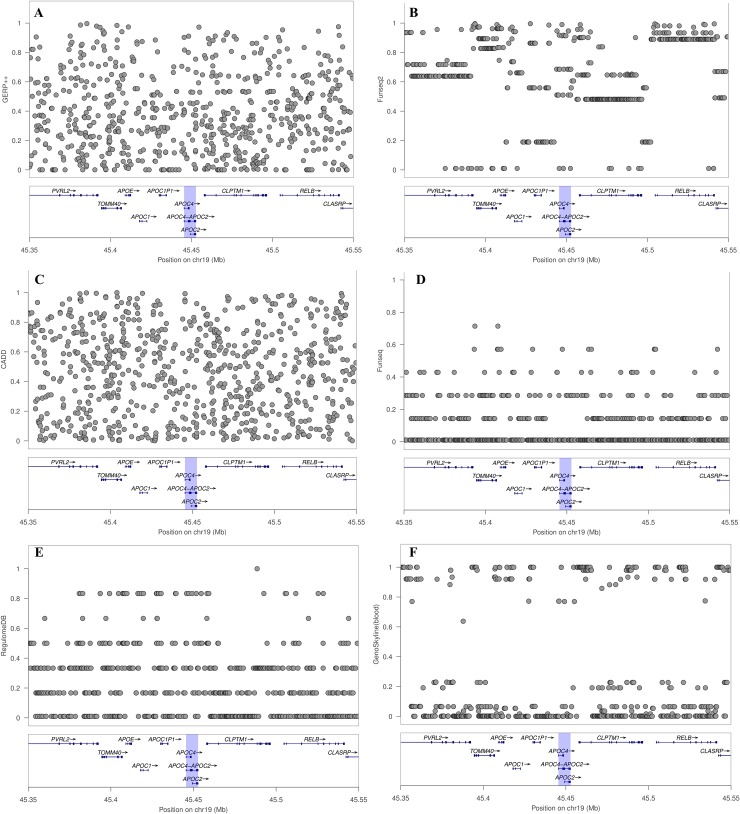
Rescaled scores of functional annotations: (A) GERP++, (B) Funseq2, (C) CADD, (D) Funseq, (E) RegulomeDB, and (F) GenoSkyline (blood) at the locus around gene APOC4-APOC2. The scores were rescaled to the interval [0, 1].